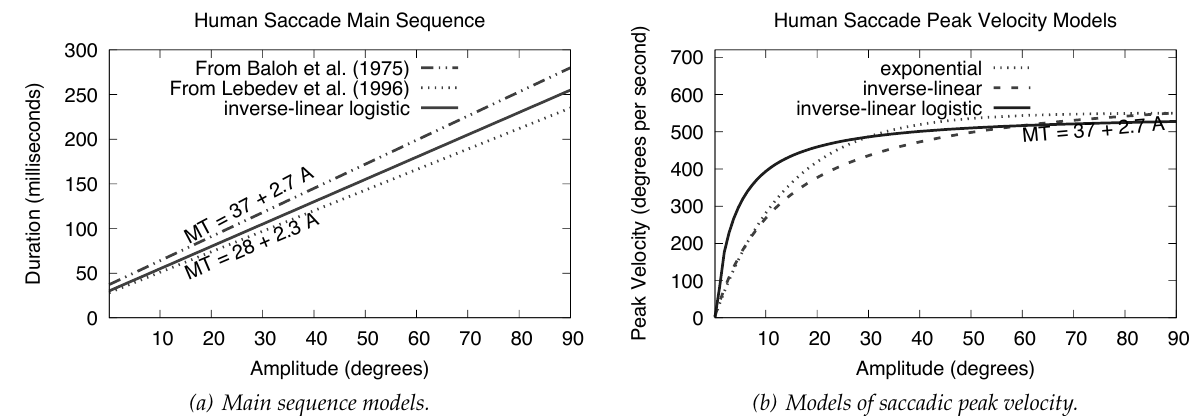
Figure 1 . Interdependence of saccadic main sequence parameters: (a) linear duration-amplitude expressions from Baloh, Sills, Kumley, and Honrubia (1975), Collewijn, Erkelens, and Steinman (1988), and our inverse-linear logistic function (see text); (b) relation of saccadic peak velocity to amplitude matching duration-amplitude relation in (a), modeled as exponential expression provided by Baloh et al. (1975), an inverse-linear derivation, and our inverse- linear logistic expression (see